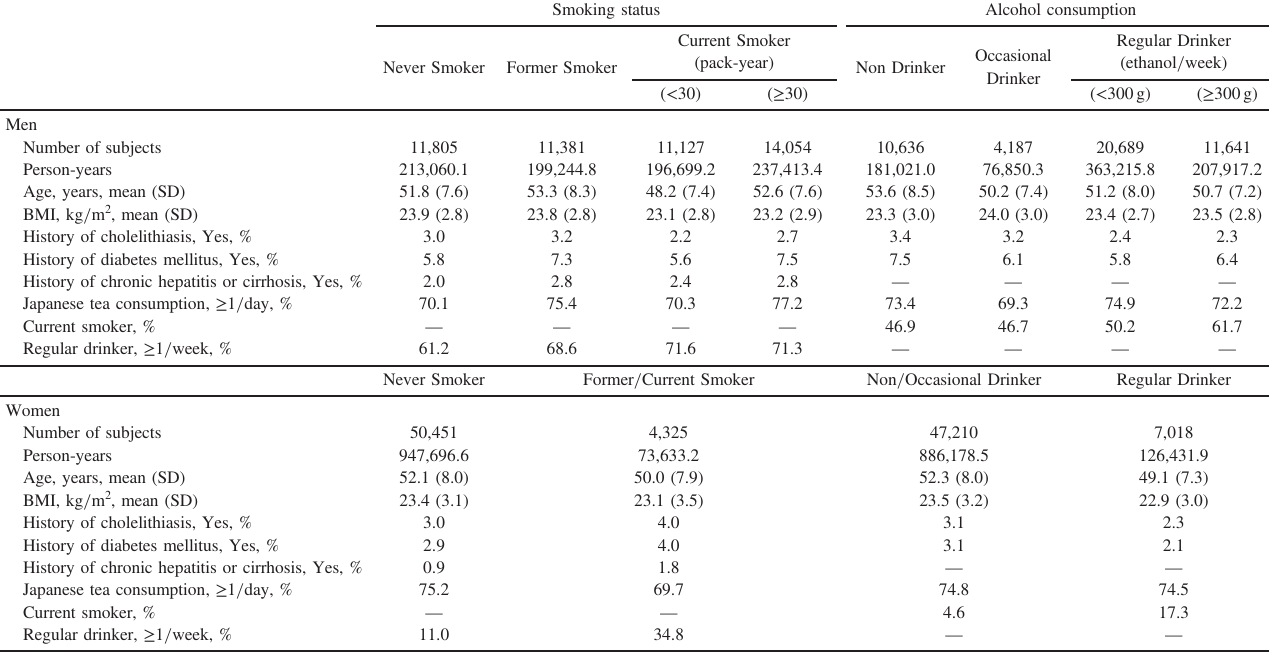
CI, con fi dence interval; HR, hazard ratio; IR, incidence ratio; SD, standard